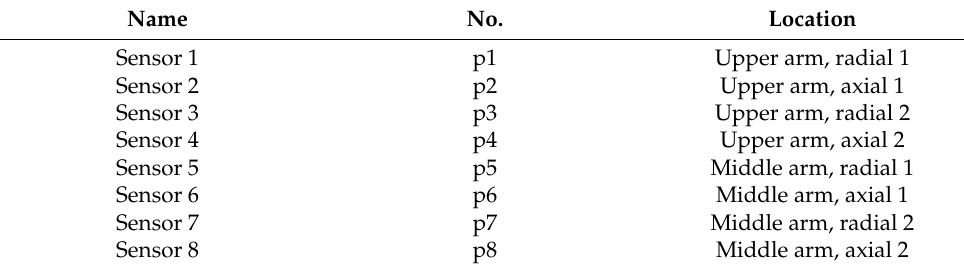
Table 1. Eight-channel strain gauge sensor